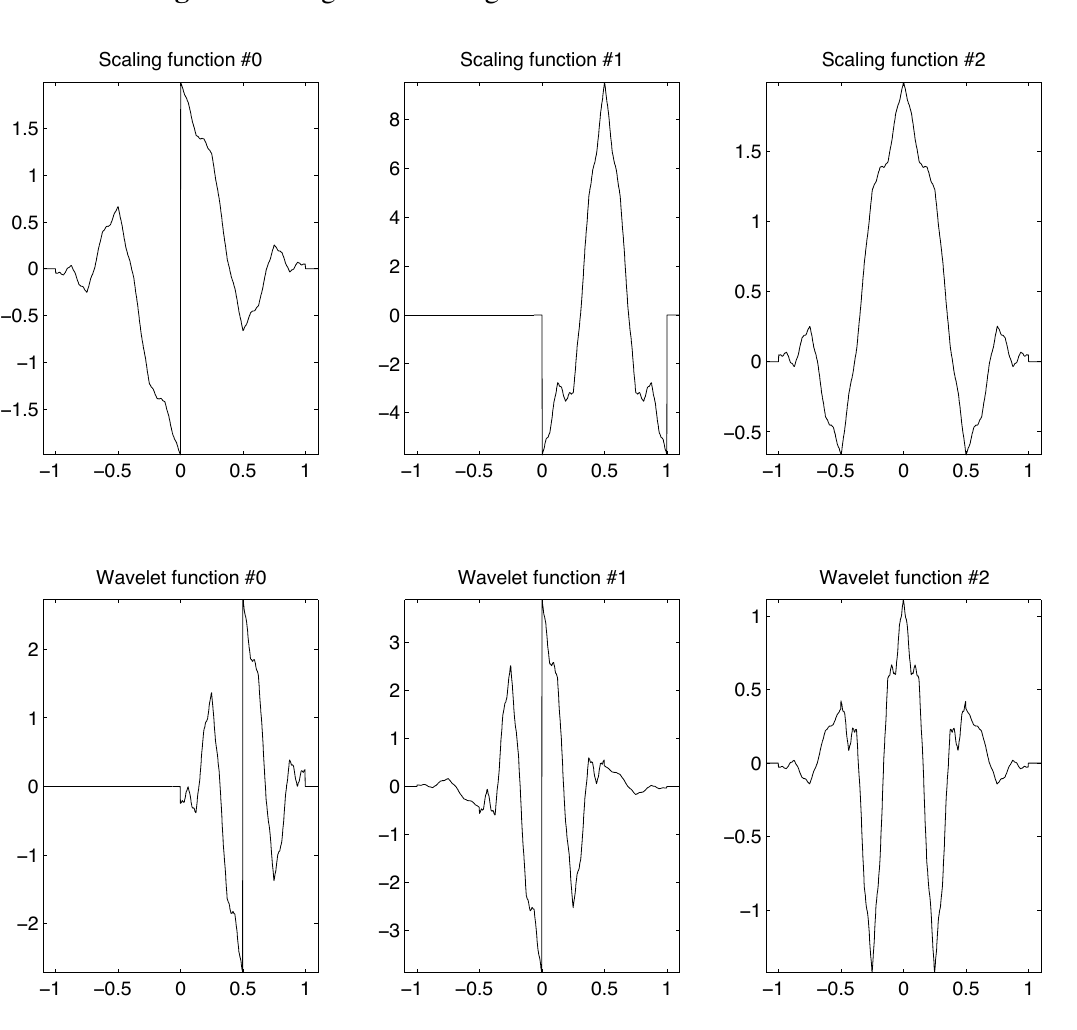
Figure 3. Roughened scaling vector Φ − and multiwavelet Ψ −